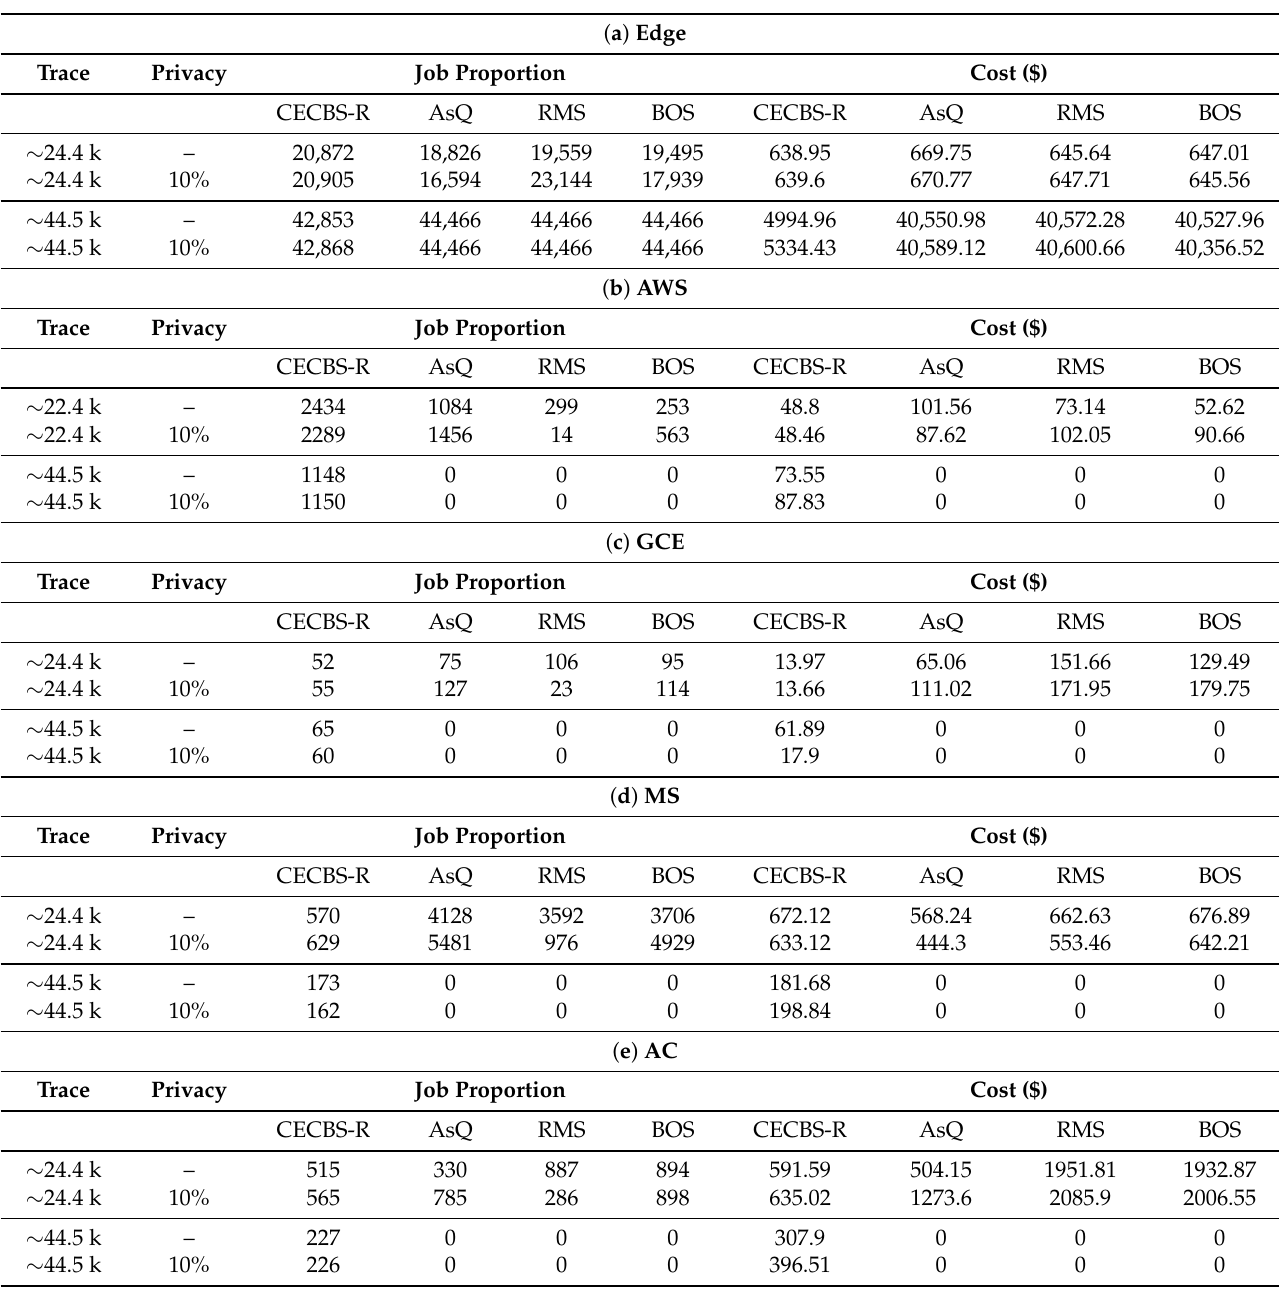
Table 7. Edge-cloud job proportion and its cost under volatile ( ω v ) electricity rates. ( a )